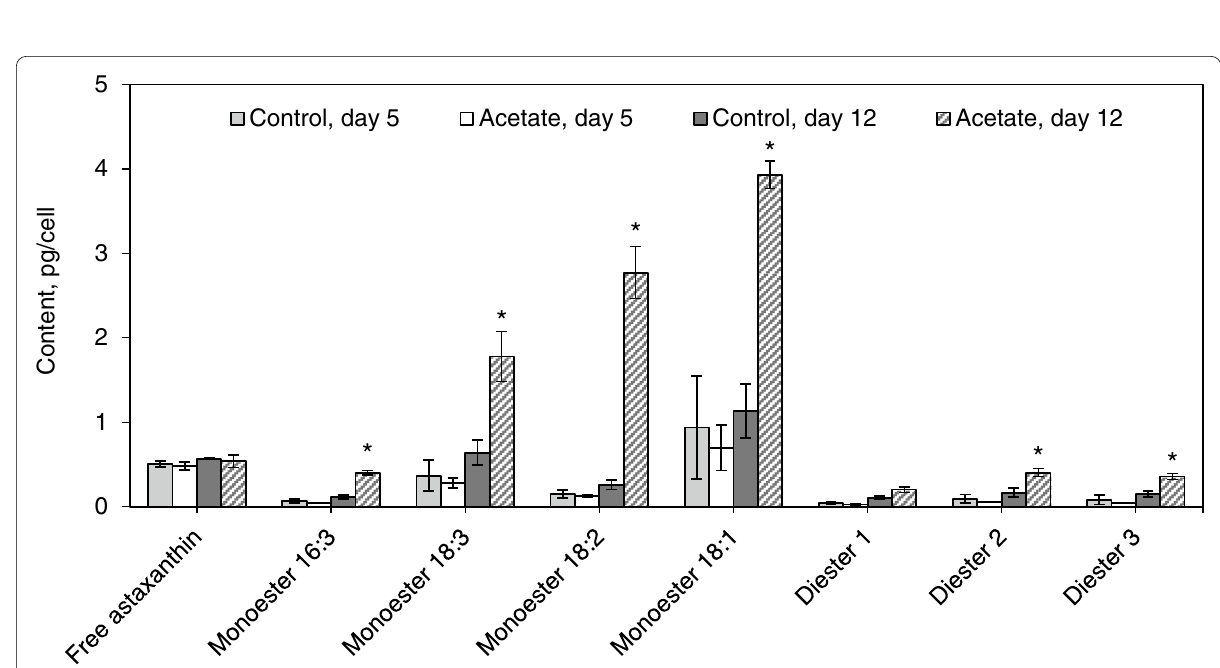
Fig. 6 Content of astaxanthin and its fatty acid esters in H. pluvialis cells after 5 and 12 days of cultivation under stress conditions. Here, 16:3, 18:3, 18:2, and 18:1 indicates hexadecatrienoic, linolenic, linoleic, and oleic acid